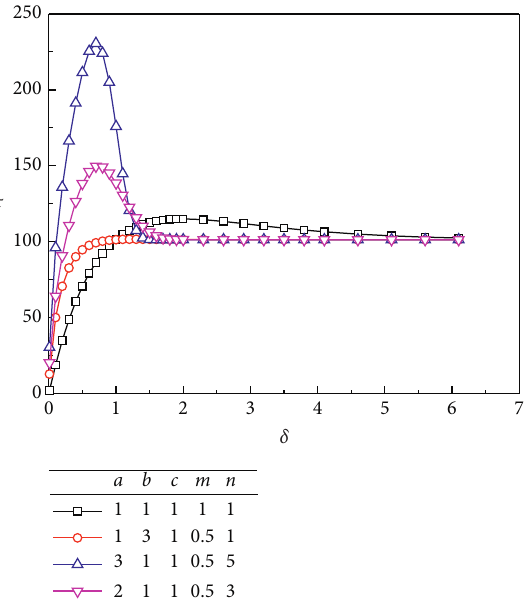
Figure 5: The shear stress versus horizontal displacement with different parameters.